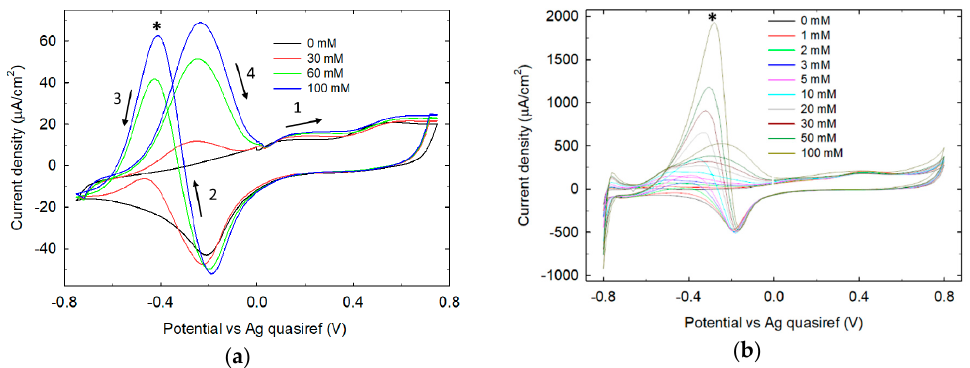
Figure 7. Glucose titration on untreated Pt SPE ( a ) and on phosphate buffer 0.1 M LIFT treated Pt SPE ( b ). The asterisks mark the upward peaks relevant to the cathodic sweeps, while arrows indicate the direction of potential sweeping.